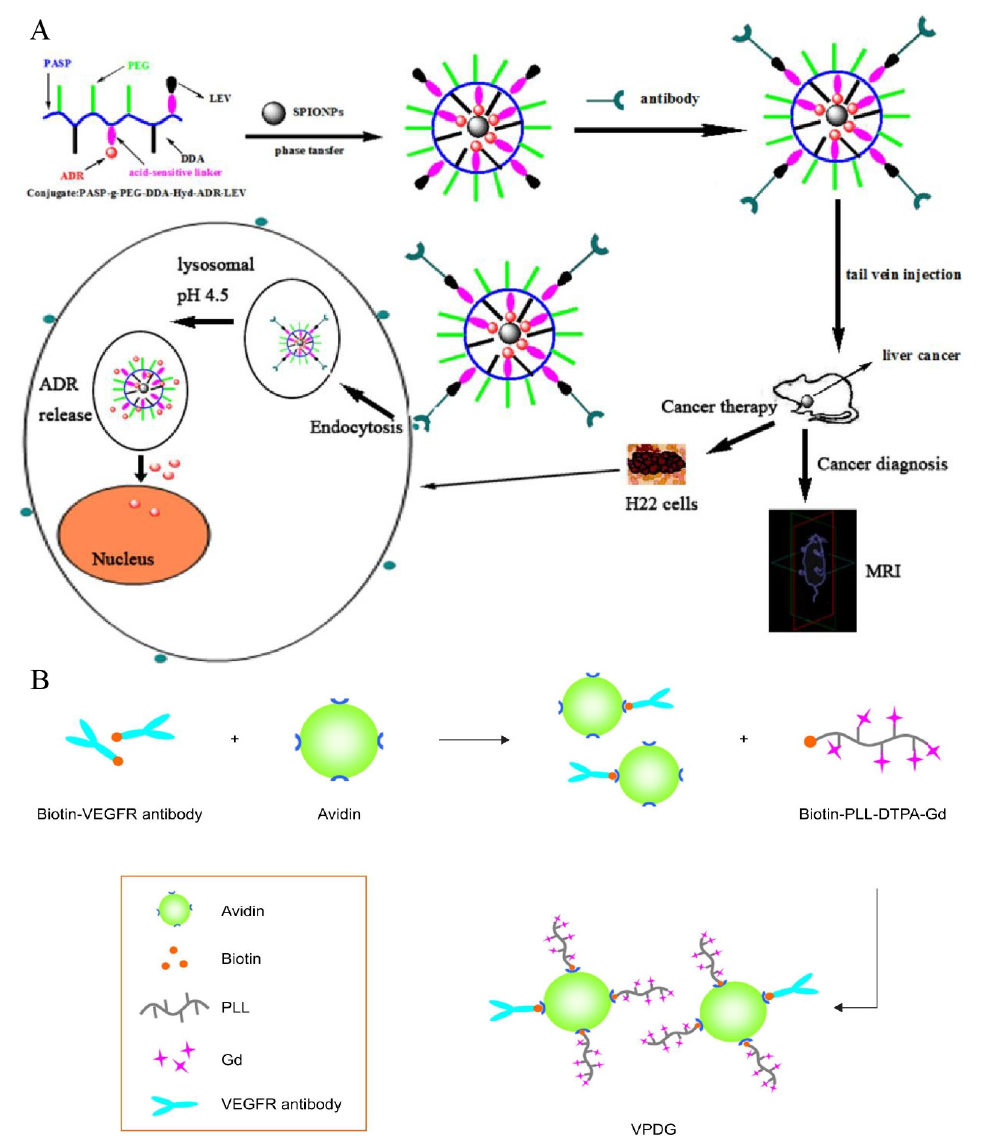
Figure 9. ( A ) Preparation of molecular probes targeting VEGF. Reproduced with permission Ref. [68]. Copyright 2013 Wiley Online Library. ( B ) The synthesis of probes targeting VEGFR. Reproduced with permission Ref. [69]. Copyright 2017